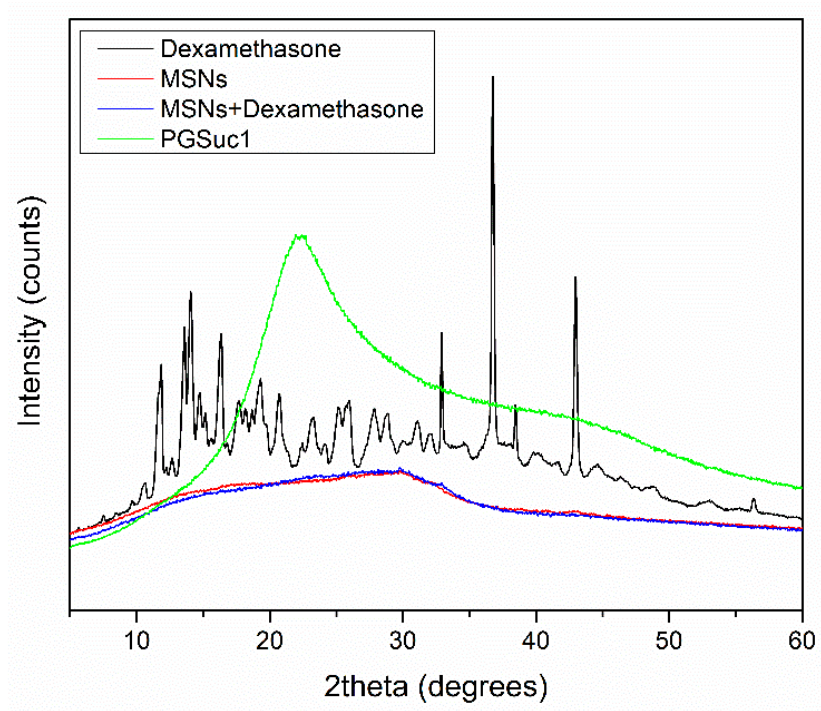
Figure 7. XRD diffractograms of PGSuc1, dexamethasone, MSNs and loaded MSNs.